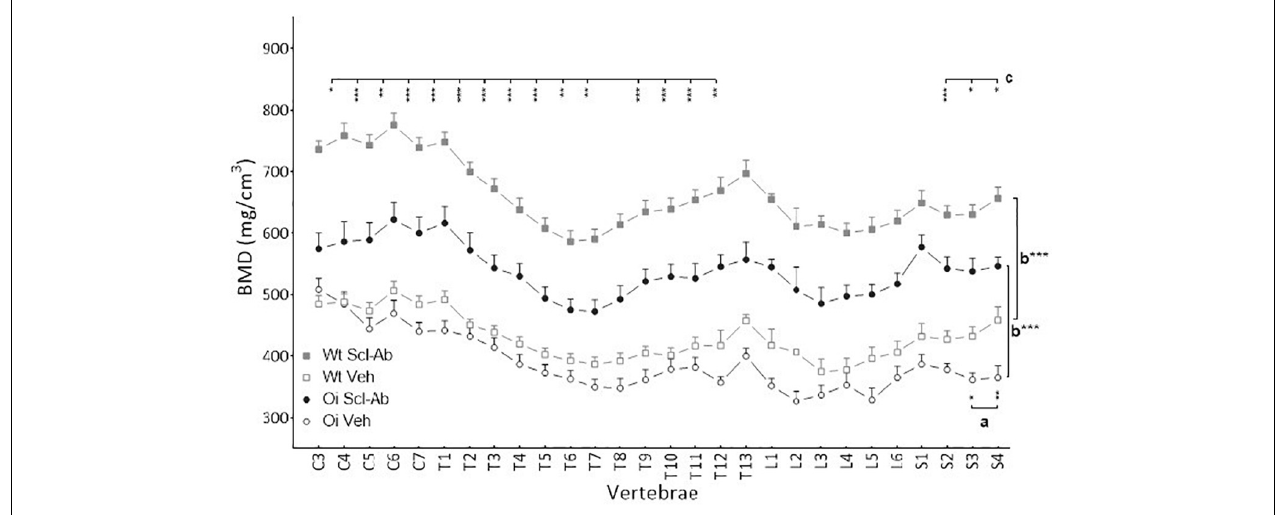
FIGURE 1 | Vertebral body bone mineral density (BMD) from C3 to S4 assessed by sagittal pQCT in male wild-type (Wt) and oim/oim (OI) mice after 9-week treatment with either Scl-Ab or vehicle (Veh.). Results are expressed as mean + SEM; a = OI Veh. versus Wt Veh.; b = Scl-Ab versus Veh., c = OI Scl-Ab versus Wt